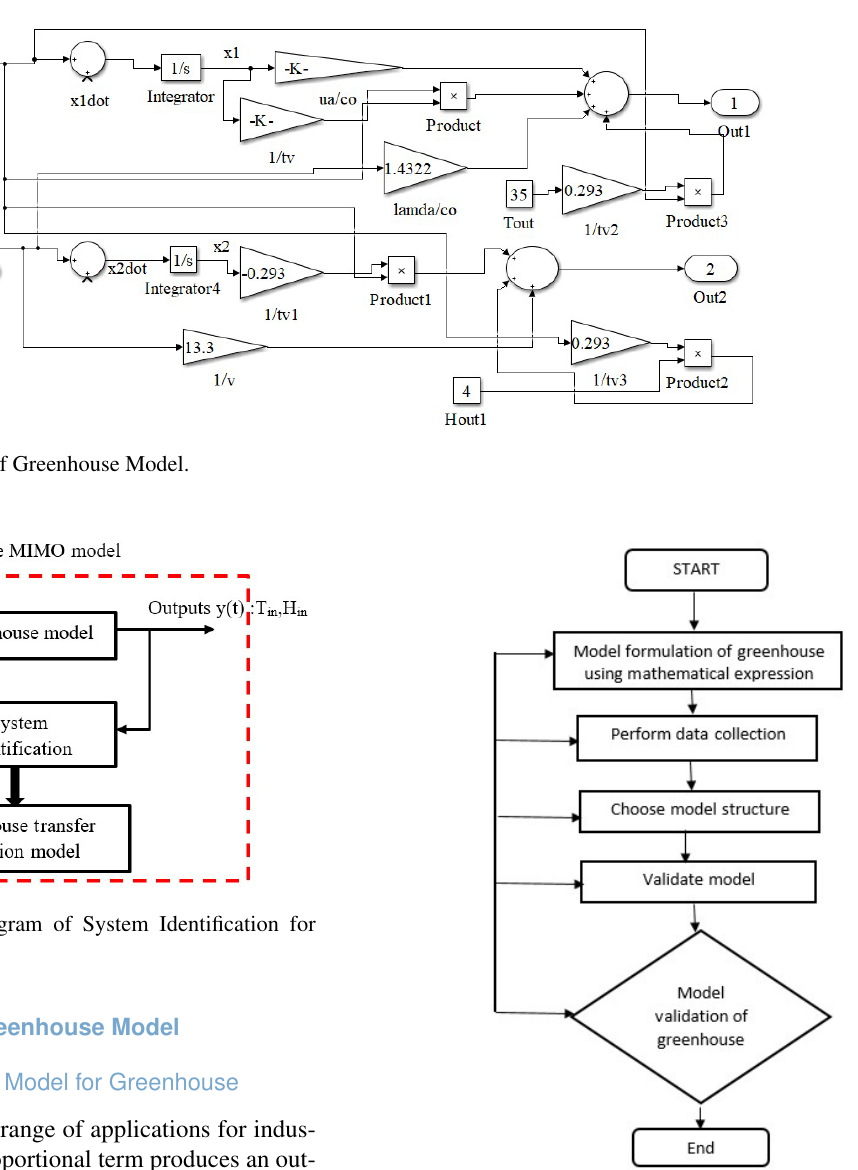
Figure 5. Flowchart of System Identification for Greenhouse